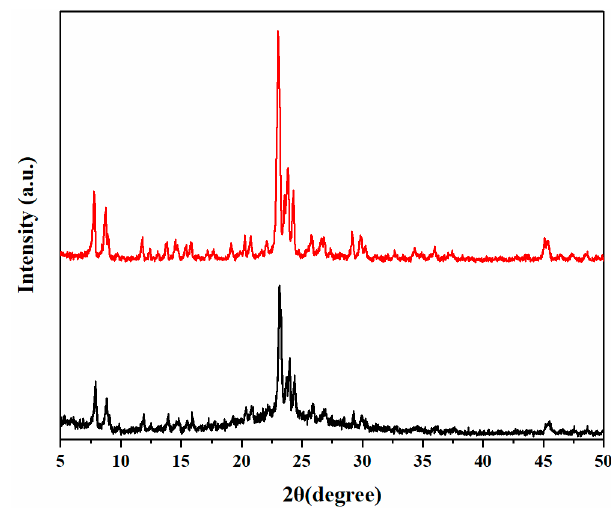
Figure 8. The XRD patterns of Samples 10 and 11.